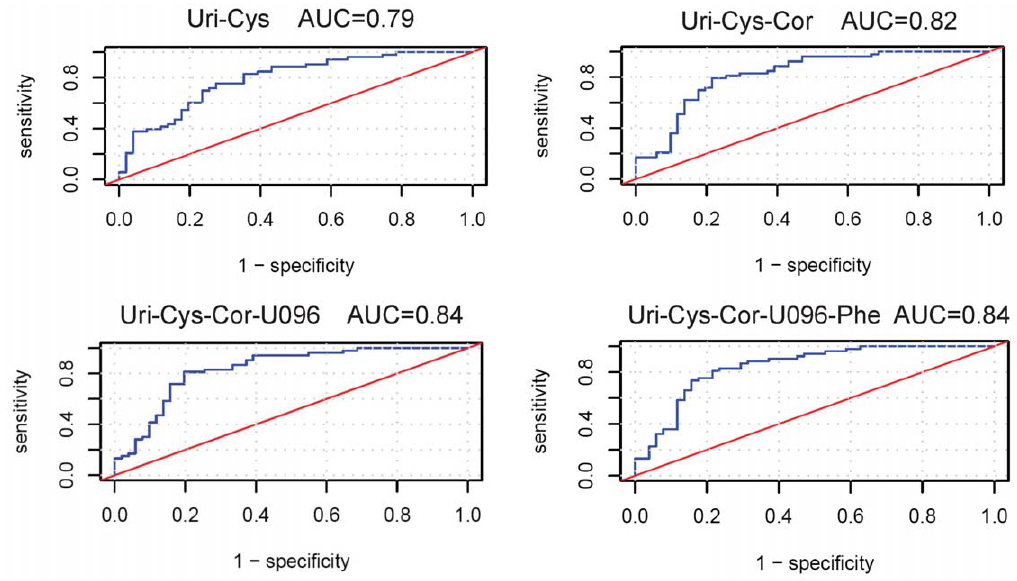
Figure 7. Receiver operating characteristics (ROC) curves with AUC values for best analyte pair (top left), triplet (top right), quartet (bottom left) and quintet (bottom right). Sensitivity (true positive rate) and 1 – specificity (false positive rate) relate to correct prediction of AD (MMSE . 22).